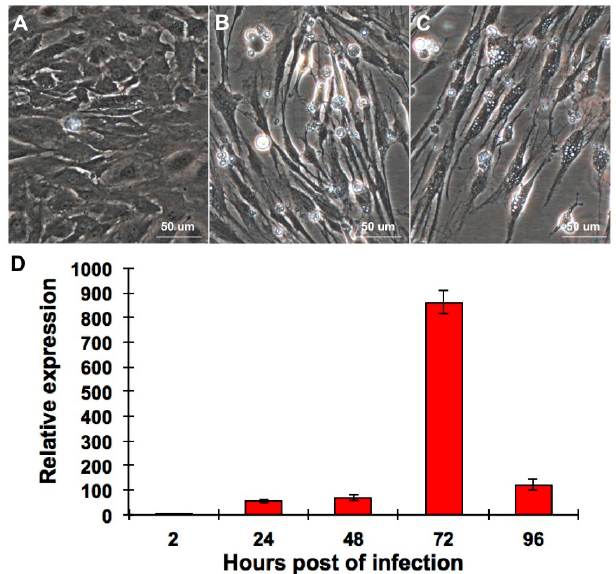
Figure 1. ( A ) Mock-infected CPB cells; ( B ) RGNNV-infected CPB cells at three days p.i.; ( C ) RGNNV-infected CPB cells at seven days p.i.; ( D ) The qRT-PCR was performed to quantify RGNNV replication in CPB cells. CPB cells were infected with 0.01 MOI of RGNNV and the relative expression of capsid protein gene of RGNNV was detected at different time point p.i. β -actin was used as internal reference gene.